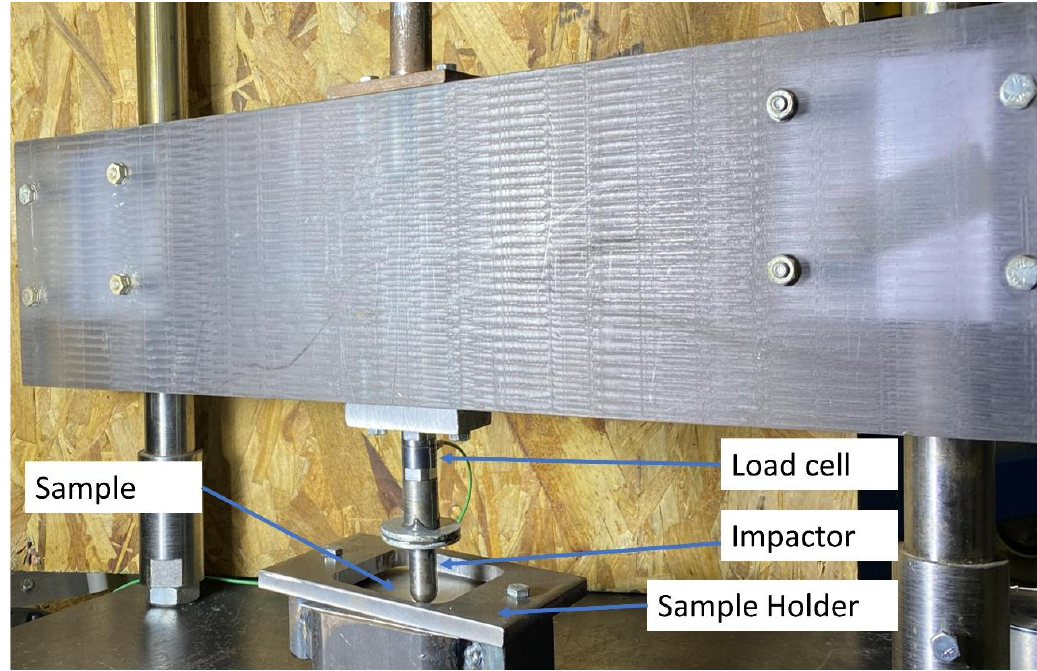
Figure 3. Impact tower and sample holder used to perform the low velocity impact tests. Table 2. Impact energy evaluated for each investigated material.